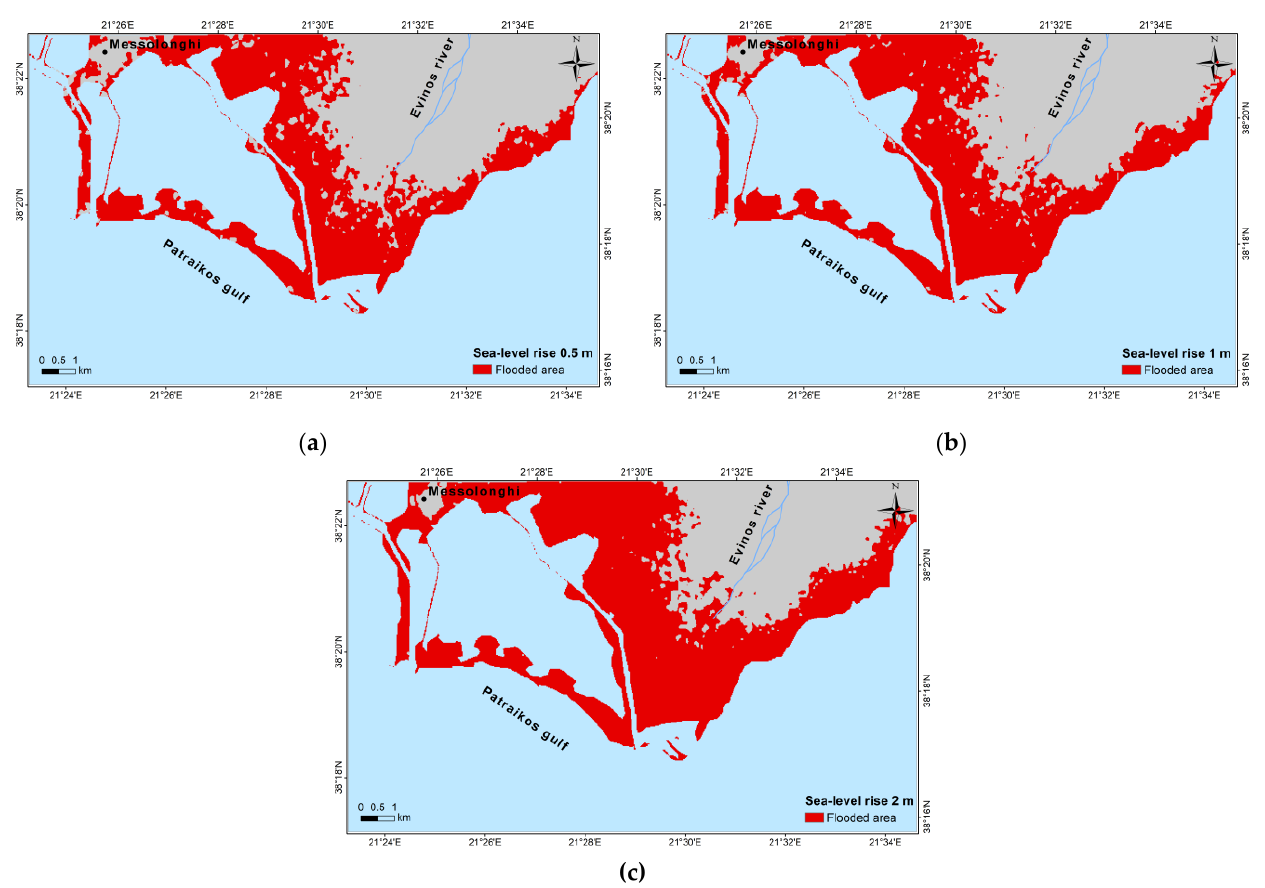
Figure 6. Flood inundation maps for ( a ) 0.5 m, ( b ) 1 m, and ( c ) 2 m sea-level-rise scenarios. The red color represents underwater areas. Table 2. Land-use categories and flooded area per land-use category for each sea-level-rise scenario (land-use data were obtained from Corine Land Cover map, of the year